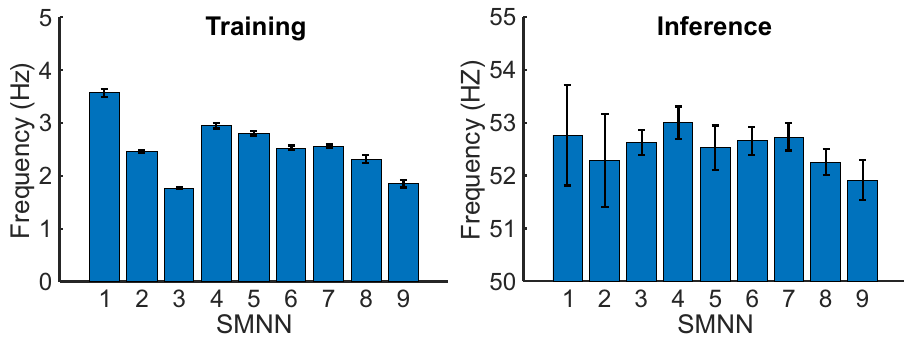
Figure 5. Running time comparison for neural network architectures SMNN 1–9. Mean training and inference frequency (number of samples per second) are shown for each model. Error bars denote standard deviation